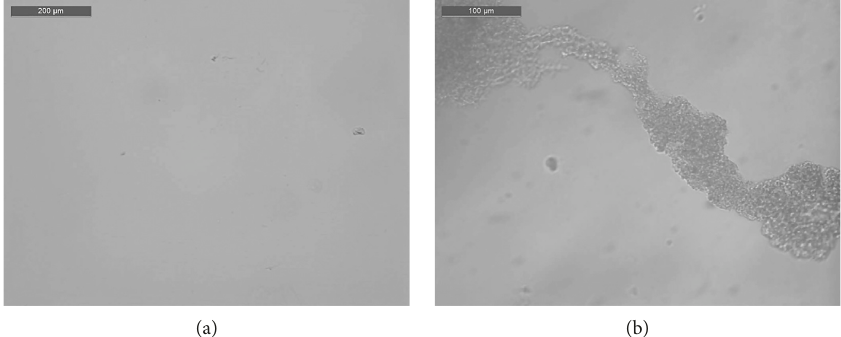
Figure 2: Micrographs of hydrogels obtained by adding (a) CS/CMC at a ratio of 75/1 and (b) CMC/CS for a ratio of 75/1.